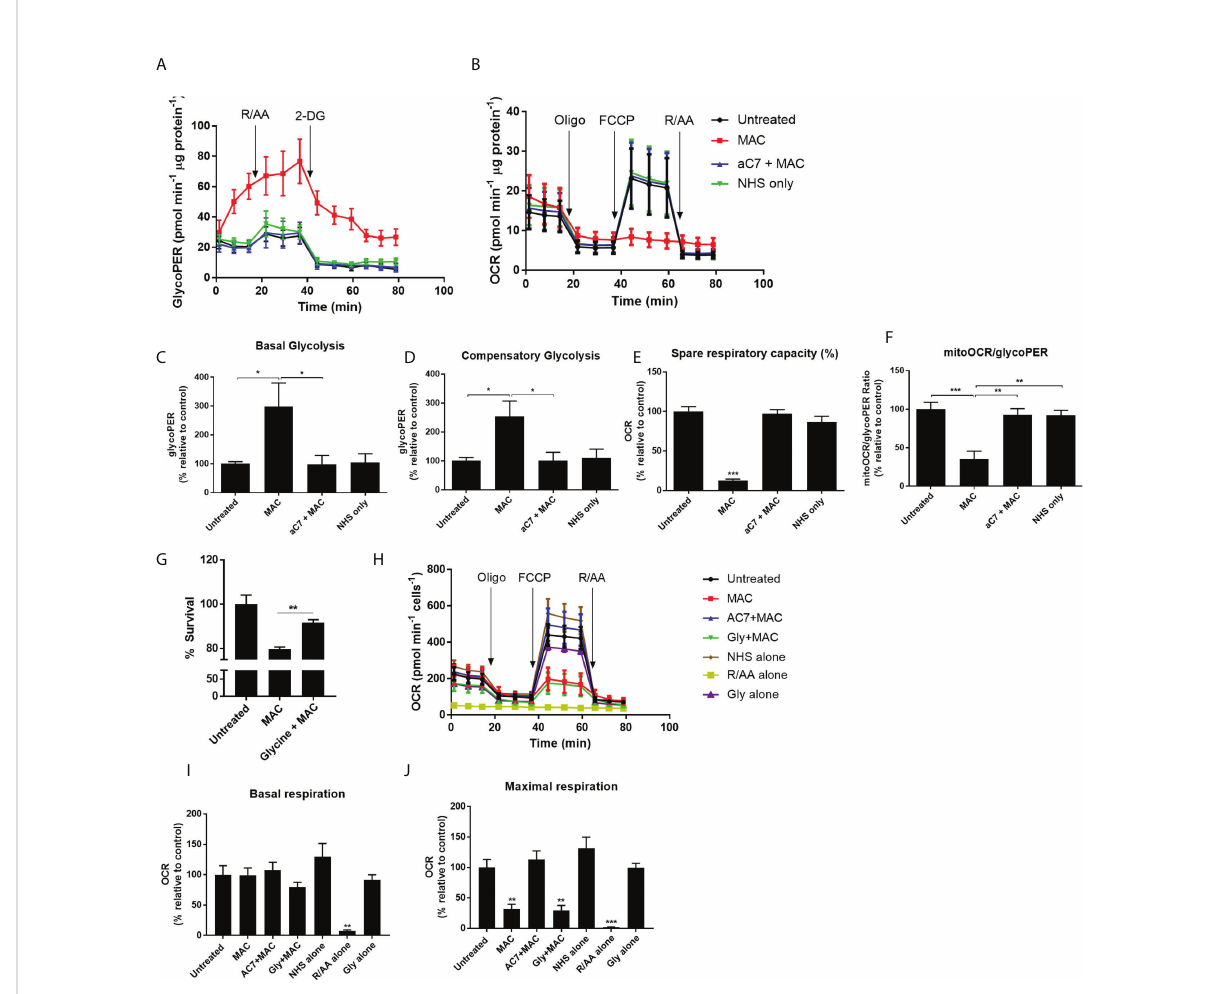
FIGURE 4 Real-time kinetic metabolic analysis by Seahorse XF technology reveals mitochondrial perturbations and glyolytic upregulation. (A – F) hMDMs stimulated with MAC, anti-C7 + MAC or NHS only (no complement sensitising antibodies prior to NHS) before running a Glycolytic Rate Test (A, C, D) or Mitochondrial Stress Test (B, E) (n=4). Parameters in C-F were calculated using Wave software. (G) hMDMs were incubated with 5 mM glycine prior to MAC stimulation for 4 hours and cell viability was measured by CellTitre-Glo. (n=3) (H – J) Mitochondrial stress test of hMDMs incubated with MAC or MAC + anti-C7, Glycine + MAC, NHS alone (no antibodies, serum only), Rotenone/Antimycin A (0. 5 uM) or glycine alone (5 mM) for 4 hours prior to initiation of Seahorse assay (n=3). (H) kinetic trace; (I) basal respiration; (J) maximal respiration. Statistical signi fi cance between MAC and all the other control groups was assessed by (G) unpaired student ’ s t-test with Welch ’ s correction for unequal SDs or (C – F, I, J) a 1-way ANOVA with post-hoc Tukey ’ s test. Error bars represent mean ± S. E. M. * = p<0.05, ** = p<0.01, *** =